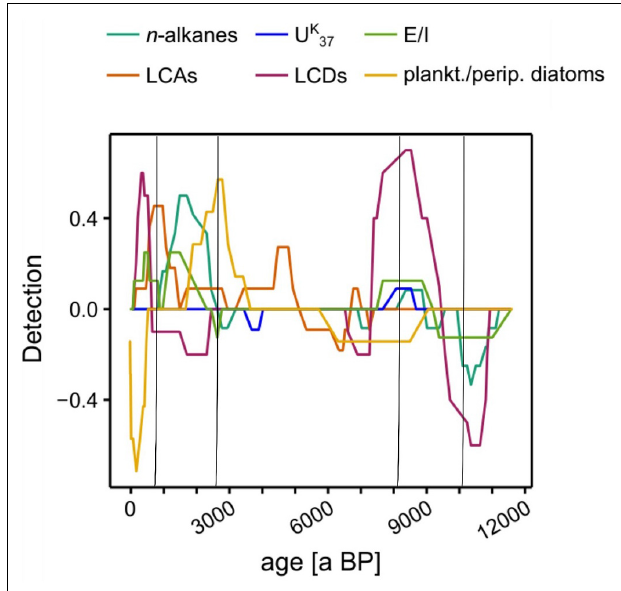
FIGURE 7 | Shift detection results by asdetect. The algorithm was performed on every proxy individually and subsequently stacked. Black lines indicate Phase boundaries defined by UMAP (see Figure 6